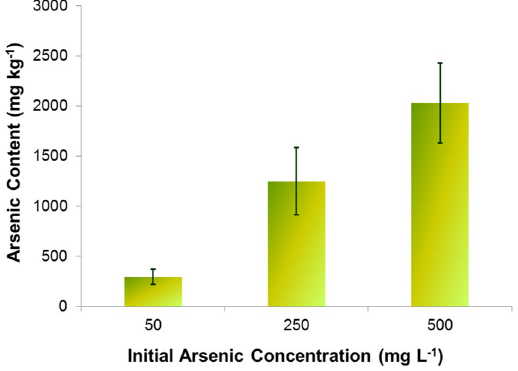
Figure 1. Arsenic uptake by Pteris vittata after 14 days. Data are expressed as mean + standard deviation.